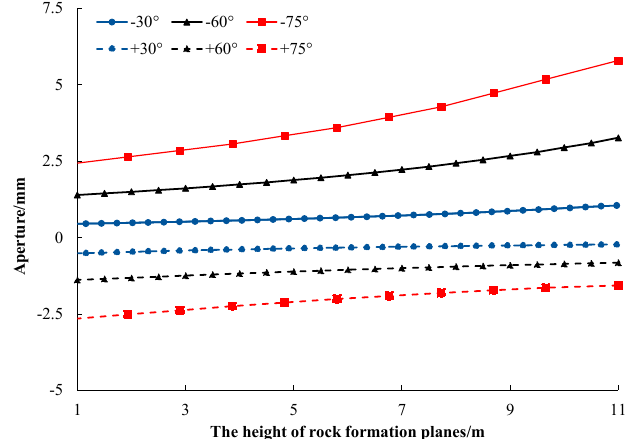
Figure 4. The calculation results of the aperture of the rock joints at different heights of the bench. Under the conditions of rock strata with different dip angles, the fracture aperture of the bedding plane showed opposite changes. The fracture aperture of dipping-in-face strata gradually increased with the increase of the height of the bedding plane. The larger the inclination angle of the layered rock, the larger the changes of the fracture aperture.